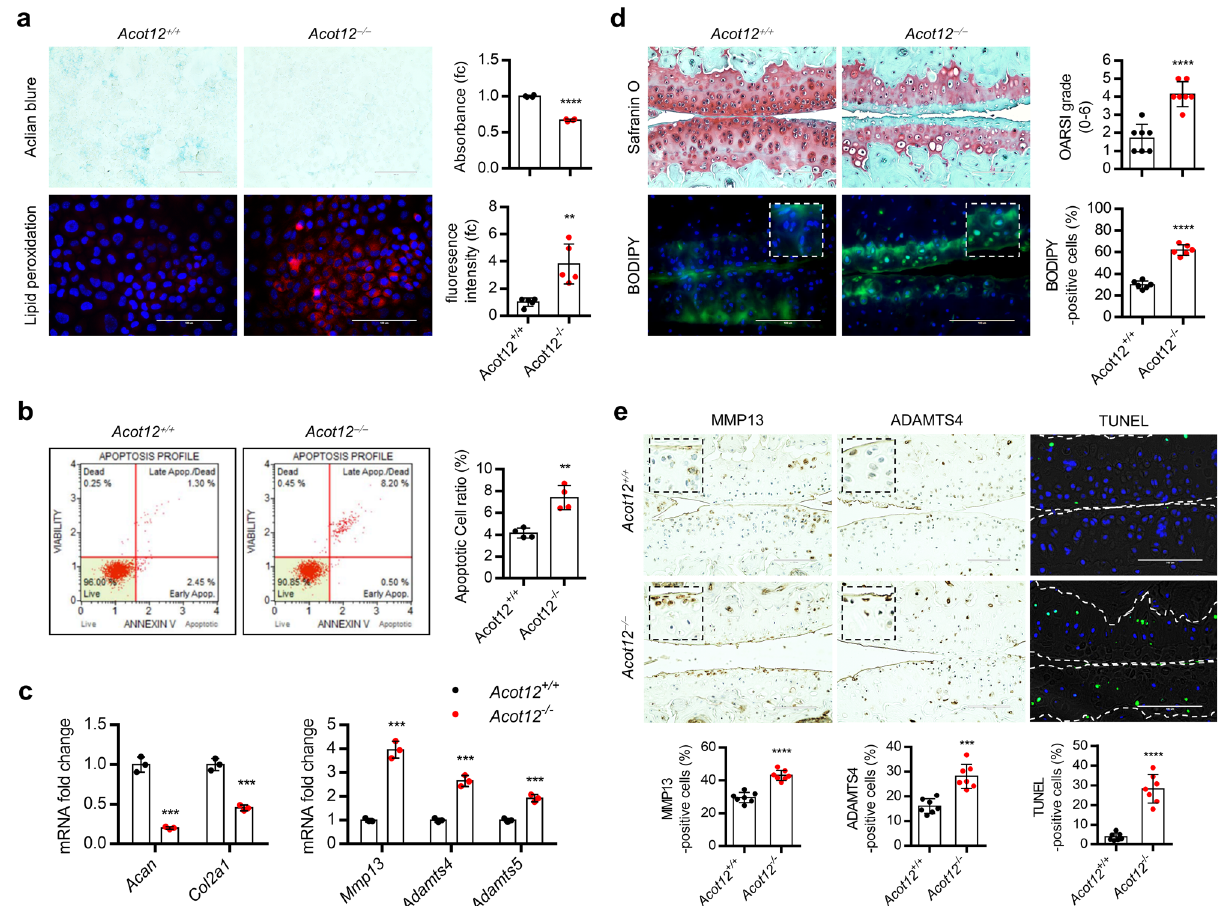
Fig. 4 ACOT12 is involved in maintaining cartilage homeostasis. a Alcian blue ( n = 3) and lipid peroxidation ( n = 5) staining in Acot12 + / + and Acot12 − / − iMACs treated with 5 ng/ml IL-1 β , P < 0.0001 for Alcian blue, P = 0.0030 for lipid peroxidation. b Analysis of apoptotic cell death ( n = 4) in Acot12 + / + or Acot12 − / − iMACs, P = 0.0016. c Expression level of Acan ( P = 0.0001), Col2a1 ( P = 0.0004), Mmp13 ( P = 0.0002), Adamts4 ( P = 0.0003), and Adatms5 ( P = 0.0008) in Acot12 + / + and Acot12 − / − iMACs treated with 5 ng/ml IL-1 β ( n = 3). d Safranin O and BODIPY staining in cartilage of DMM-induced Acot12 + / + and Acot12 − / − mice at 8 weeks. The degree of cartilage degradation is quanti fi ed according to OARSI grade ( n = 7), P < 0.0001. Scale bar, 100 μ m. BODIPY-positive cells are indicated by bar – dot plot ( n = 6), P < 0.0001. e Immunohistochemistry of MMP13 and ADAMTS4 and TUNEL staining in the cartilage section of Acot12 + / + and Acot12 − / − mice ( n = 7). MMP13 ( P < 0.0001), ADAMTS4 ( P = 0.0001), and TUNEL-positive cells ( P < 0.0001) were indicated by bar – dot plot. Unpaired Student ’ s t test ( a , b , d , e ) or multiple t test followed by Holm – Sidak method ( c ) were used for statistical